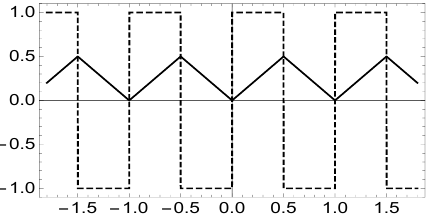
Figure 2 . Function (cid:28) ( z ) (solid line) and (cid:27) ( z ) (dashed line).